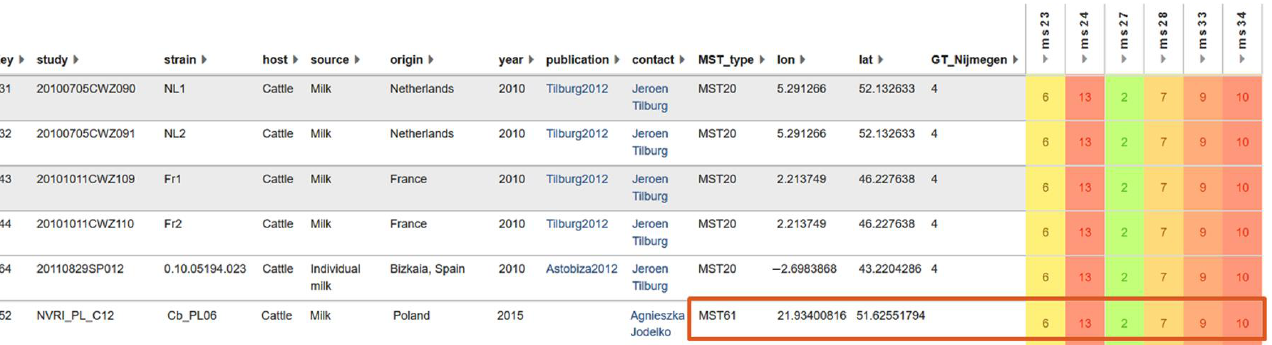
Figure 2. Identification of tandem repeat of C. burnetii . Alignment of sequences of six markers (MS23, MS24, MS27, MS28, MS33, and MS34) from the Nile Mile strain (NCBI accession No.: NC_002971 and CP035112) and the detected strain D25 is shown. The region with repeat units in each marker is indicated, and the numbers indicating the positions in the analyzed sequences are presented. Number of tandem repeats of each marker is shown.